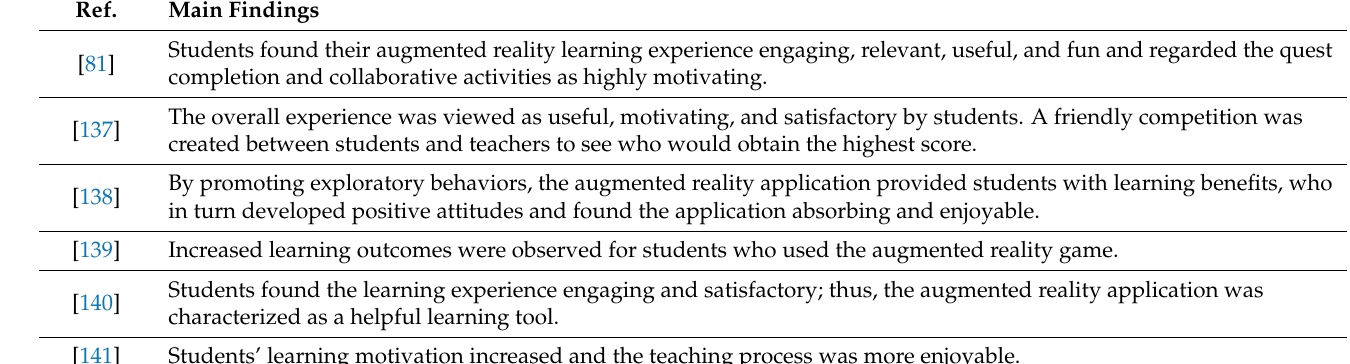
Table 4. Empirical studies: Main